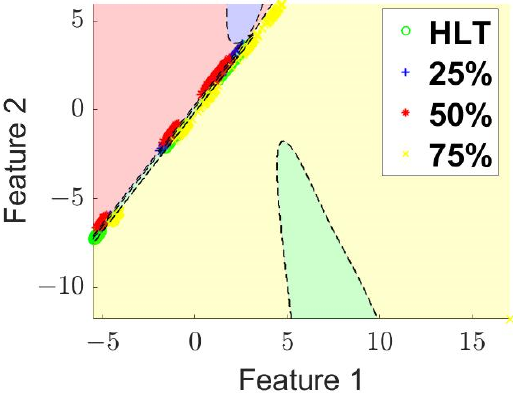
Figure 7. LDA applied over all the features in the matrix of high dimensionality.